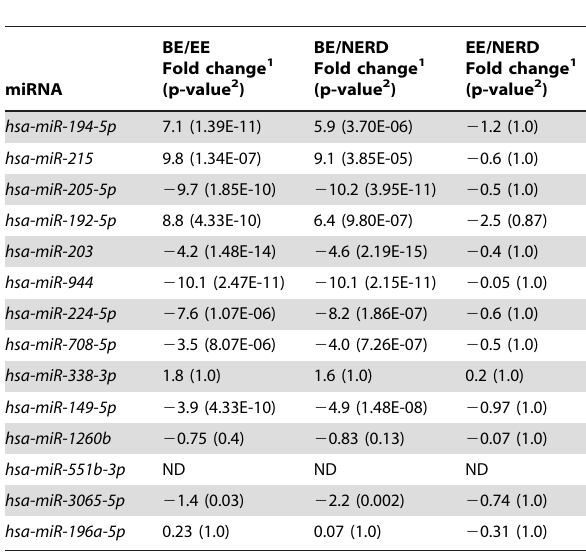
Table 2. Differentially expressed miRNA in BE compared to the GERD subgroups, EE and